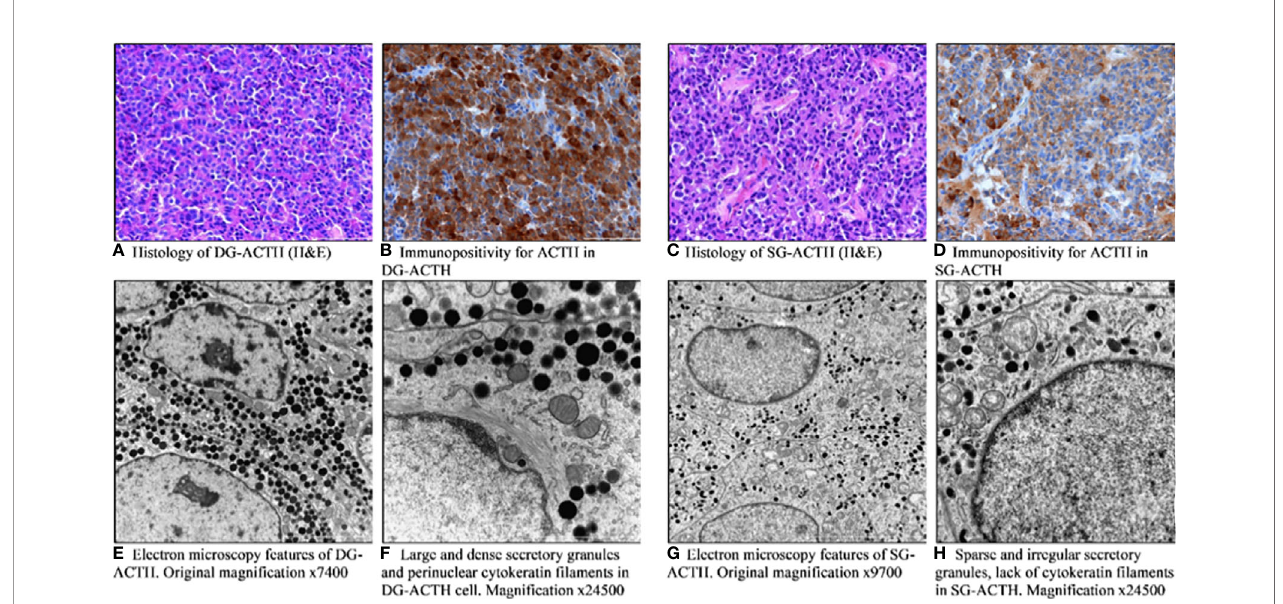
FIGURE 2 | Pathomorphological features of densely (A, B, E, F) and sparsely granulated (C, D, G, H) corticotroph pituitary tumors. (A) Histology of DG-ACTH (H&E). (B) Immunopositivity for ACTH in DG-ACTH. (C) Histology of SG-ACTH (H&E). (D) Immunopositivity for ACTH in SG-ACTH. (E) Electron microscopy features of DG-ACTH. (F) Large and dense secretory granules and perinuclear cytokeratin fi laments in DG-ACTH cell. (G) Electron microscopy features of SG-ACTH. (H) Sparse and irregular secretory granules, lack of cytokeratin fi laments in